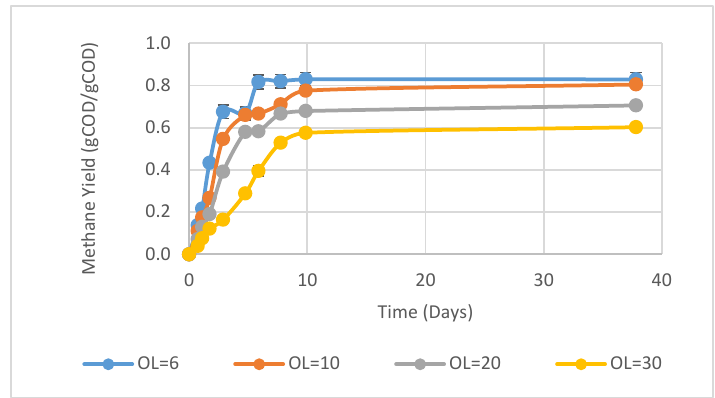
Figure 2. Methane yield of H170 under thermophilic condition under different organic loadings (OLs).